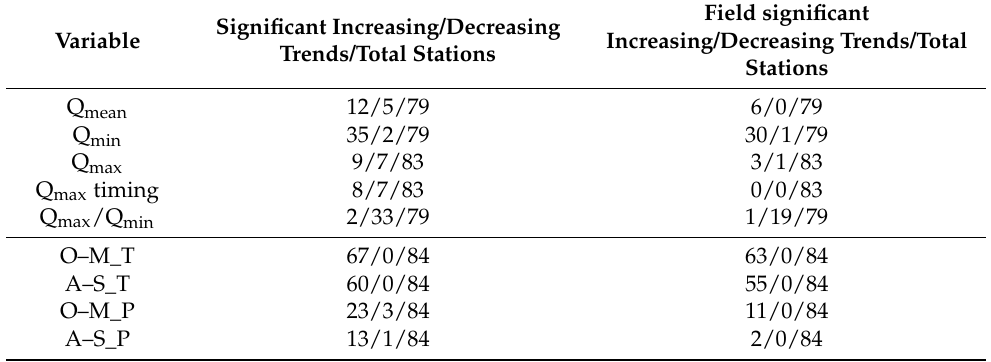
Table 1. Number of stations with significant trends ( p < 0.1) using the Mann–Kendall test with iterative pre-whitening, and the number of field significant trends with false detection rate